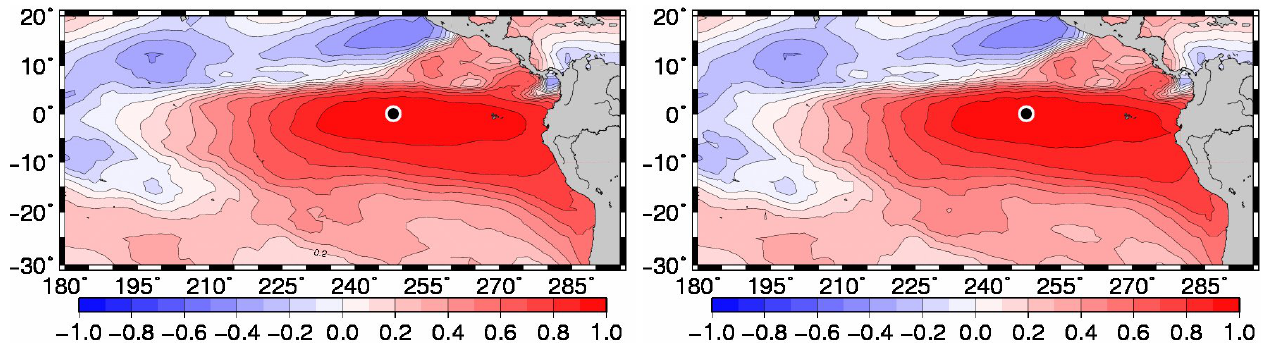
Fig. 3. SST horizontal correlation structure with respect to SST at 114 ◦ W 0 ◦ N (Eastern Equatorial Pacific), without anamorphosis (left panel), and after local anamorphosis transformations (right